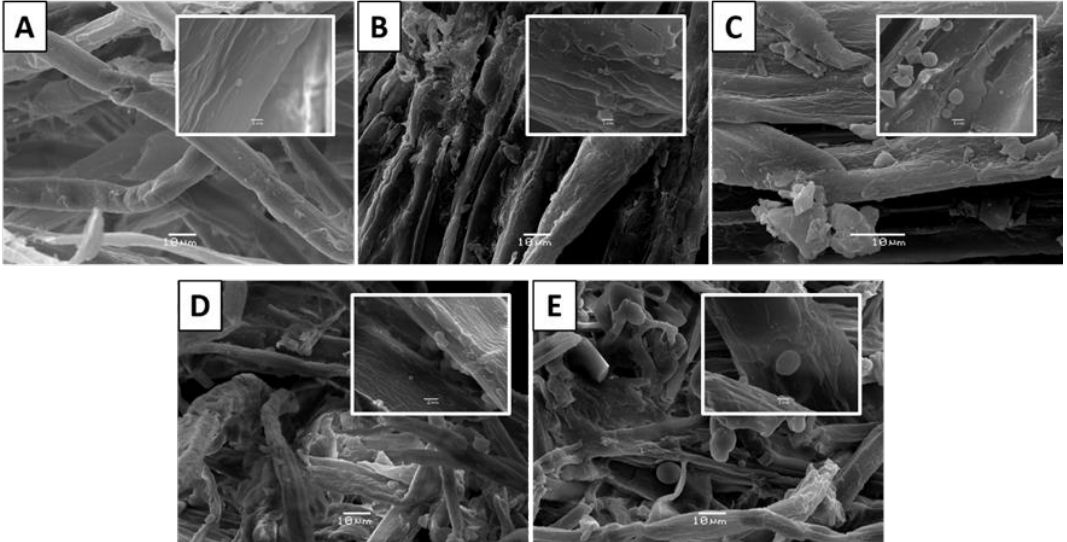
Figure 2. Surface images obtained by scanning electronic microscopy (SEM) of E. globulus pre-treated by steam explosion at different severity factors. ( A ) S 0 = 8.53; ( B ) S 0 = 9.11; ( C ) S 0 = 10.42; ( D ) S 0 = 11.63; ( E ) S 0 = 12.31. The insert shows splits, delamination, cracks, and changes in the structure of the fibres and the appearance of lignin droplets. Bar size: 10 µm; bar size in the inserted micro-image: 1 µm.